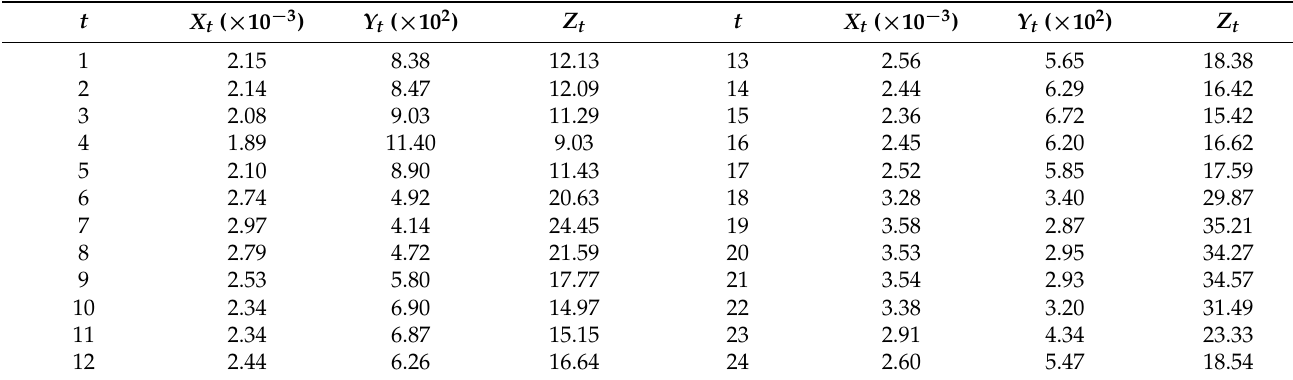
Table 3. Coefficients in Figure 6 (the day of the lowest electricity